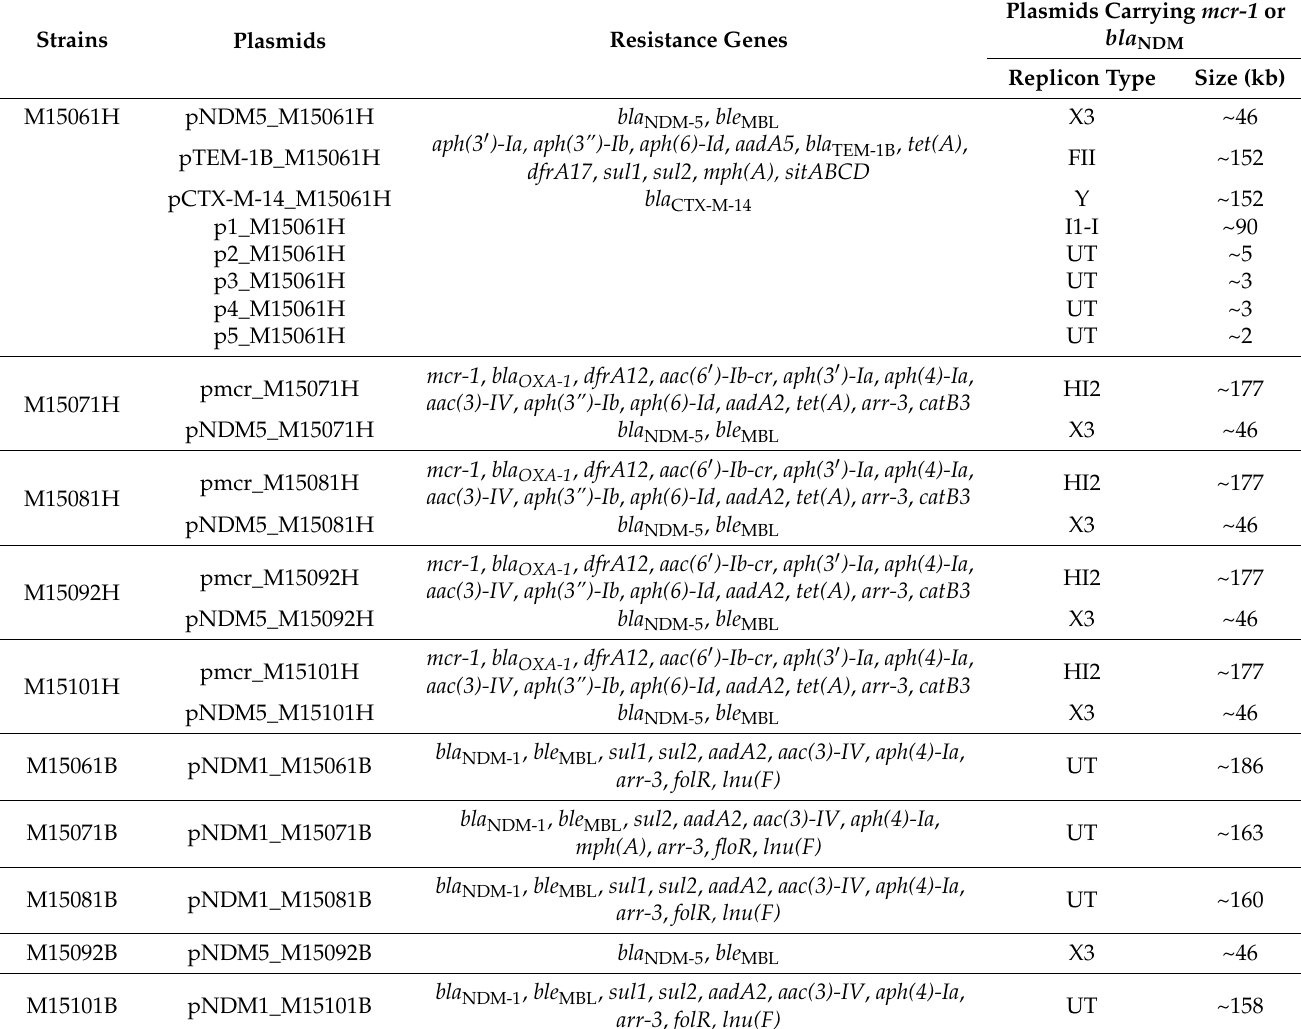
Table 4. Characteristics of plasmids harboring mcr-1 or bla NDM from fresh vegetables. Strains Plasmids Resistance Genes